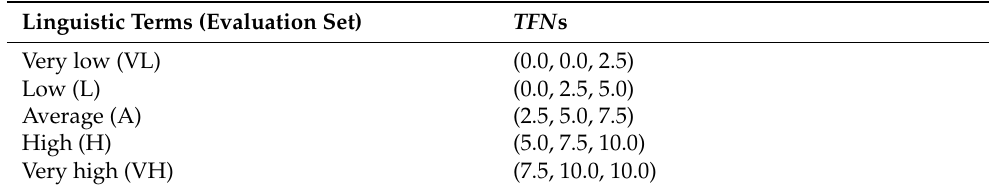
Table 4. Linguistic terms and corresponding TFN